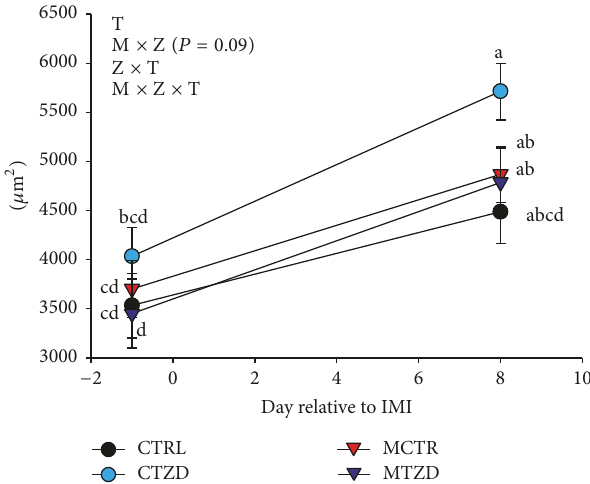
Figure 11: Area of adipocytes in subcutaneous adipose tissue col- lected from the tail-head of goats receiving intramammary infusion (IMI)of Strep.uberis (M)orsalineplusdailyintrajugularinjectionof 2,4-thiazolidinedione (TZD) or saline (CTR). Significant ( 𝑃 ≤ 0.05 ) effects and interactions are indicated in the graph (mastitis: M, time: T, and TZD: Z). Significant differences ( 𝑃 < 0.05 ) between time point are denoted by diverse